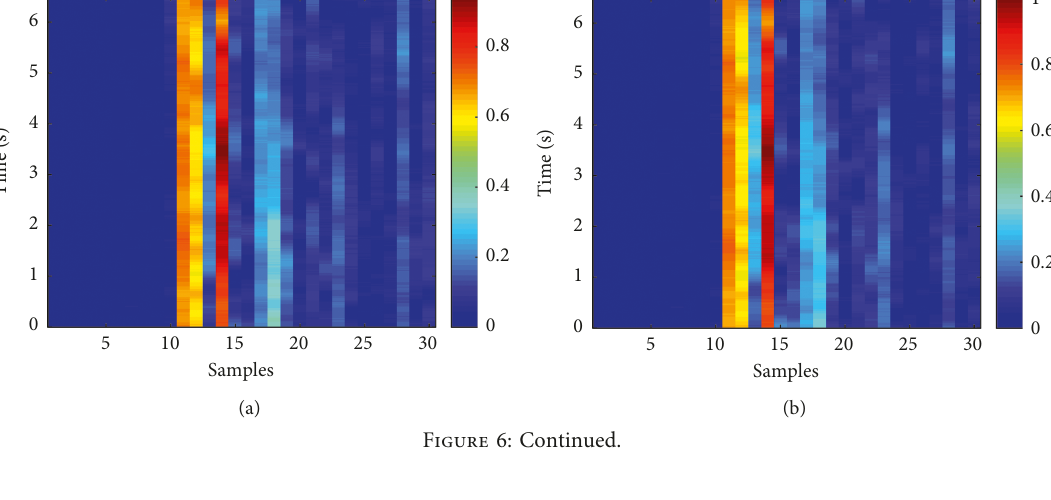
Figure 5: The measured CIRs for VS01: (a) the CIR for the pressure channel; (b) the CIR for the v (d) the temporal coherence of measured CIR.